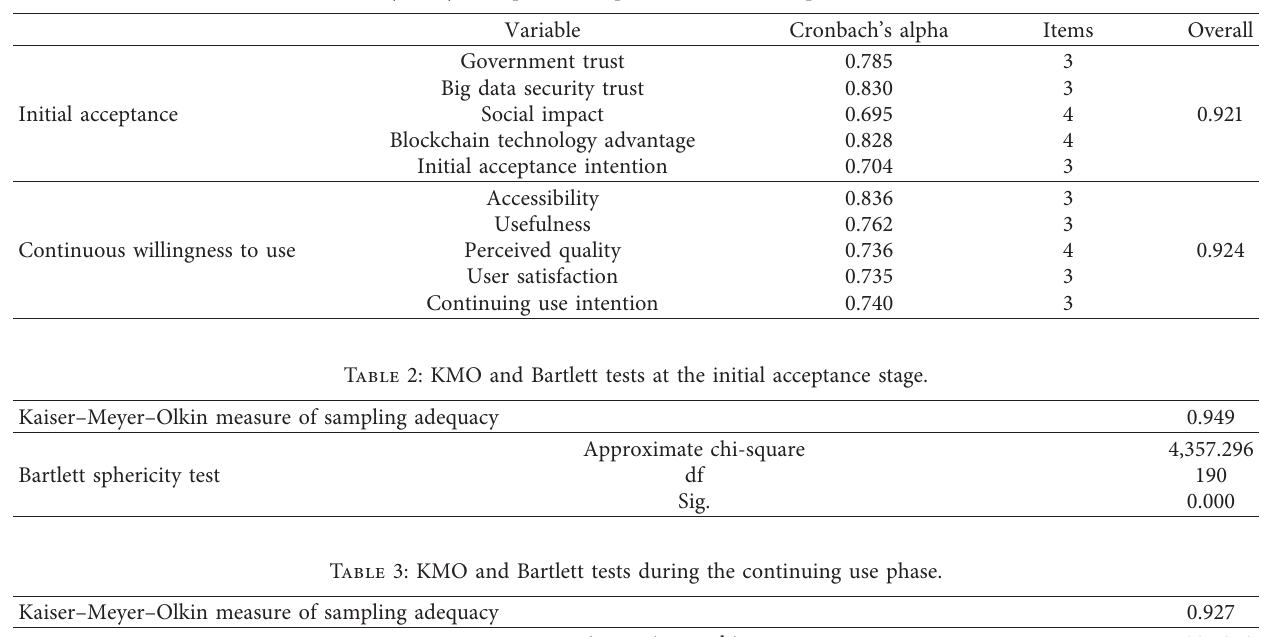
Table 1: Reliability analysis of public acceptance of initial acceptance and continued use.